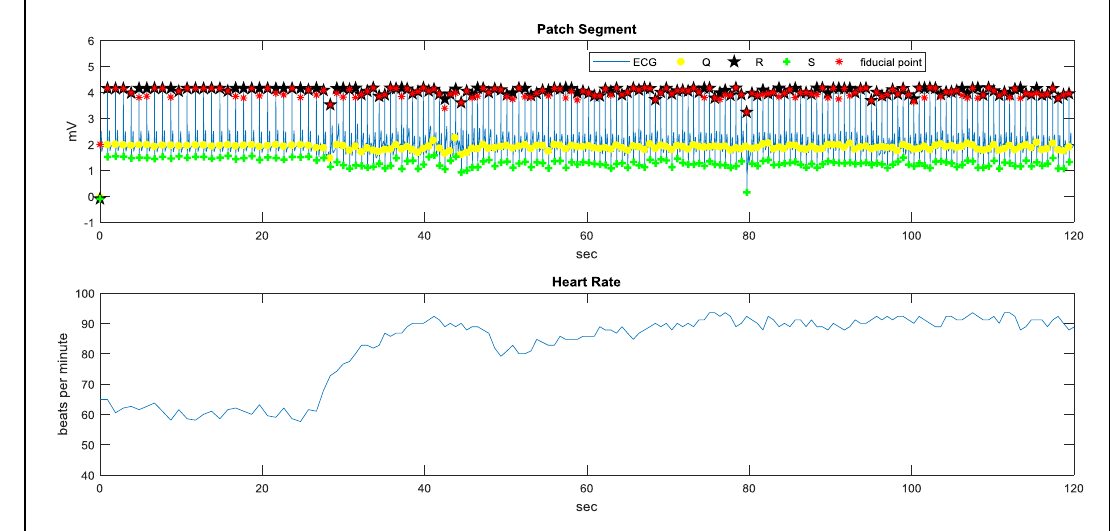
Figure 20. The results of QRS detection, R point recognition, and heart rate curve.